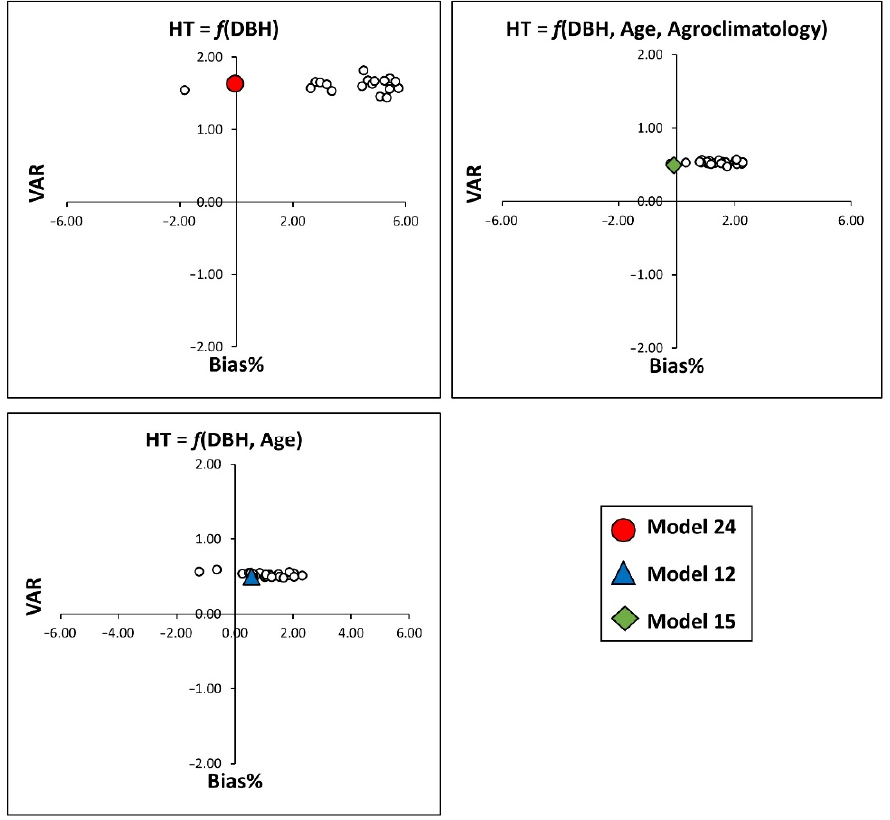
Figure 5. Graph of the relationship between bias and variance for the hypsometric modeling of Guazuma crinite Mart. trees in the Peruvian Amazon, showing with greater emphasis the best trained model for each of the three study functions: HT = f (DBH), HT = f (DBH, Age) and HT = f (DBH, Age, Agroclimatology).